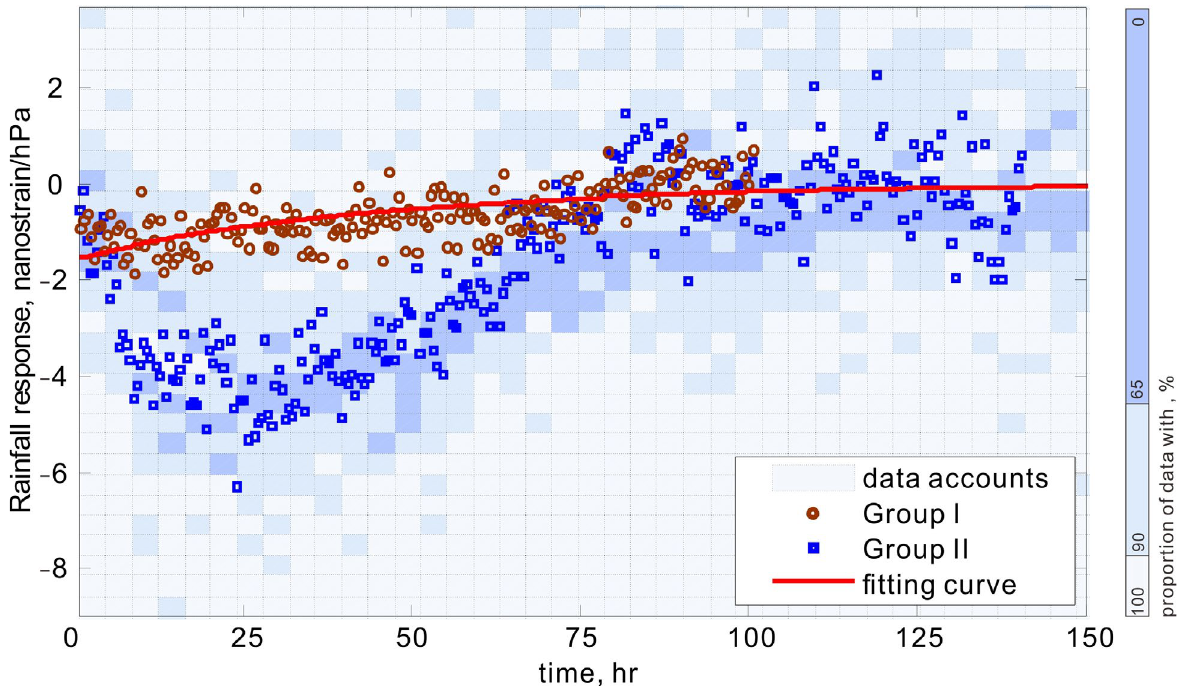
Figure 5. Rainfall impact functions of the DARB station are divided into two groups based on the rainfall responses. Basemap shows the proportion of discrete data of Group II within certain timespan. Group I includes the runoff and river-hydrological impact caused by rainfall (brown circles) and group II comprises the impact of debris avalanches on the observation stations caused by heavy rainfall (blue squares). The data of group II were stacked; the unit amounts were counted and shown as the results on the base diagram in which the darker blue area contains 65% and the lighter one contains more than 90% discrete data.